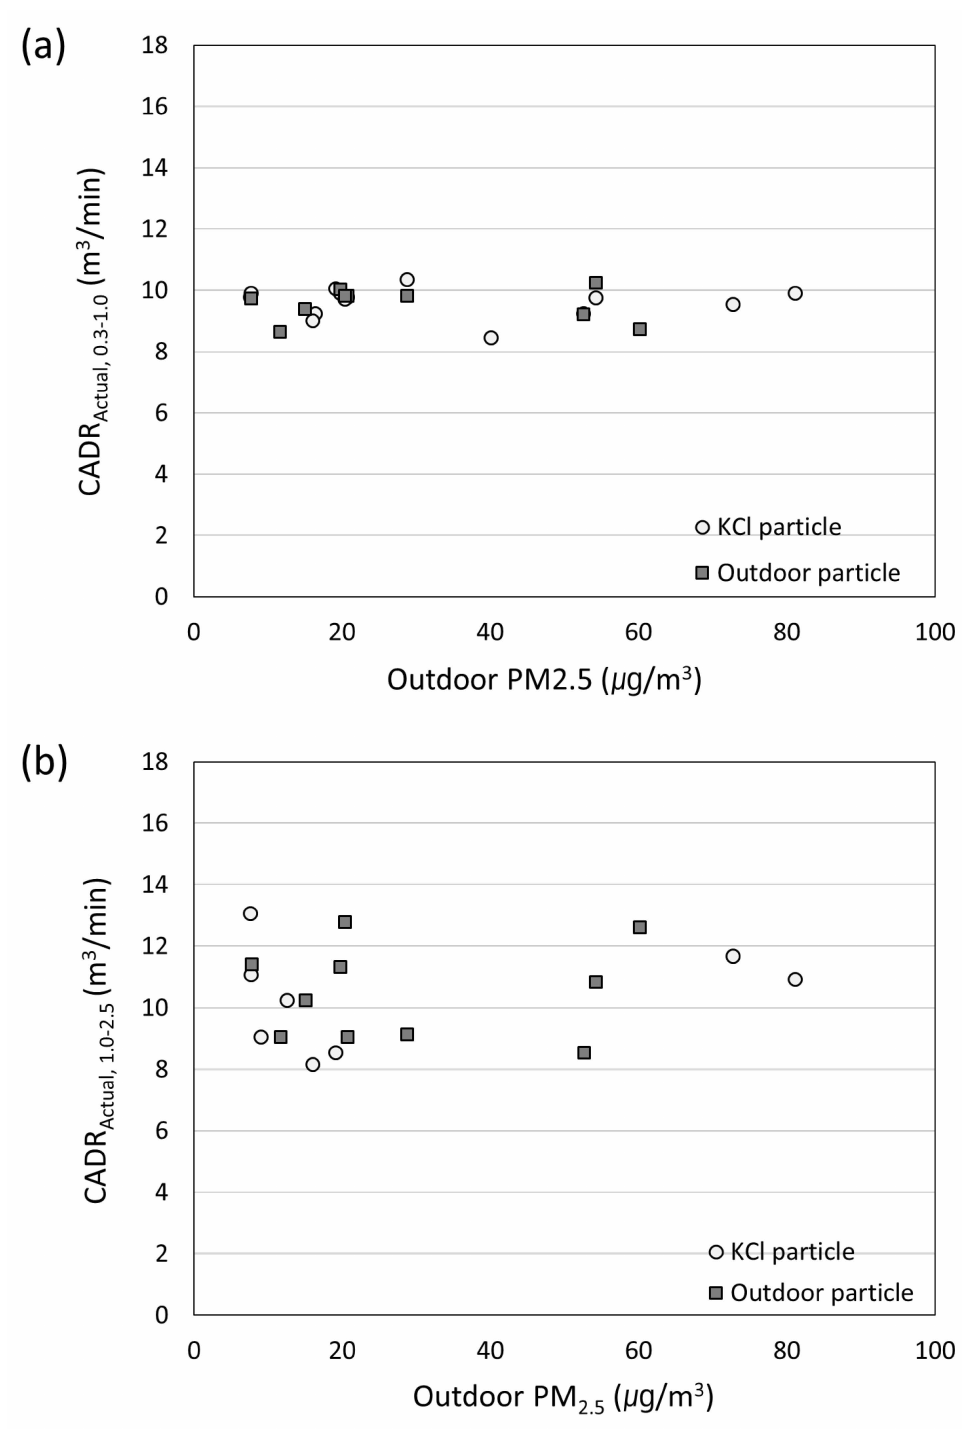
Figure 5. CADR Actual of an air purifier measured at a test house using the KCl test particles and outdoor atmospheric particles for ( a ) 0.3–1.0 µ m particles and ( b ) 1.0–2.5 µ m particles. Here, 10 measurements were performed using KCl particles and atmospheric particles to verify whether the KCl particles can be used for evaluating the performance of the air purifier in house B. The average CADR Actual depending on the outdoor PM 2.5 was found to be close to 9.62 m 3 /min for KCl particles and 9.47 m 3 /min for atmospheric particles. The corresponding standard deviations were found to be 0.49 and 0.51, thus indicating appropriate values. The average CADR Actual within the 1.0–2.5 µ m